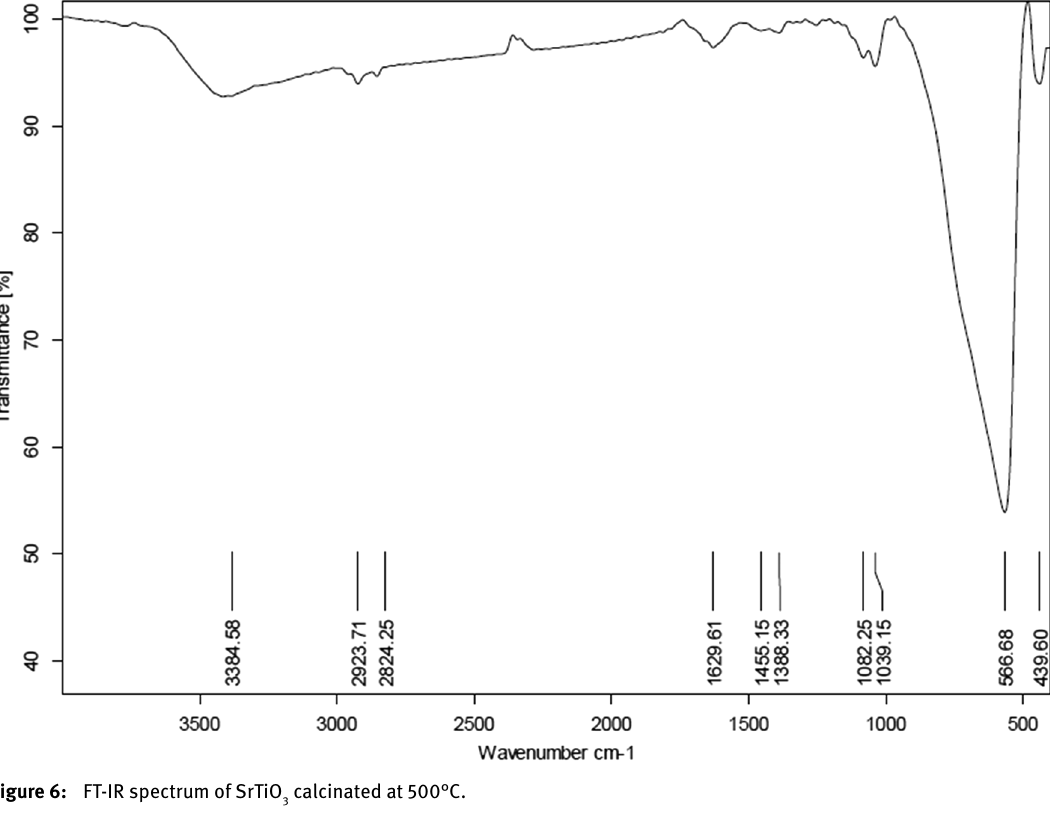
Figure 6: FT-IR spectrum of SrTiO